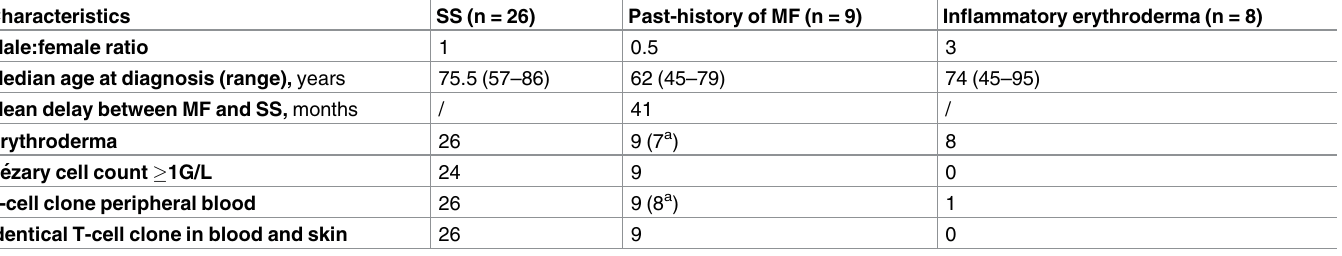
Table 1. Clinical and biological featuresof patients with primary Se´zary Syndrome (SS) or with past-history of Mycosis Fungoides (MF) at second- ary SS stage. Characteristics